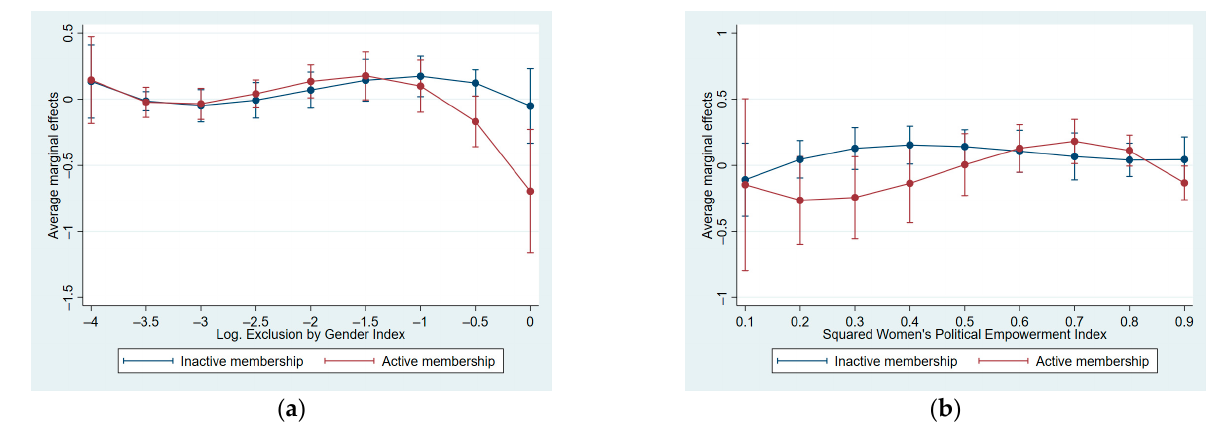
Figure A3. Average marginal effects for active and inactive membership in sports clubs on sexist gender ideologies conditioned on the log transformed EG Index ( a ) respectively conditioned on the squared WPE Index ( b ). Results for the group of women. We included 95% confidence intervals using robust standard errors. Source: WVS ‐ EVS ‐ data and V ‐ Dem data.